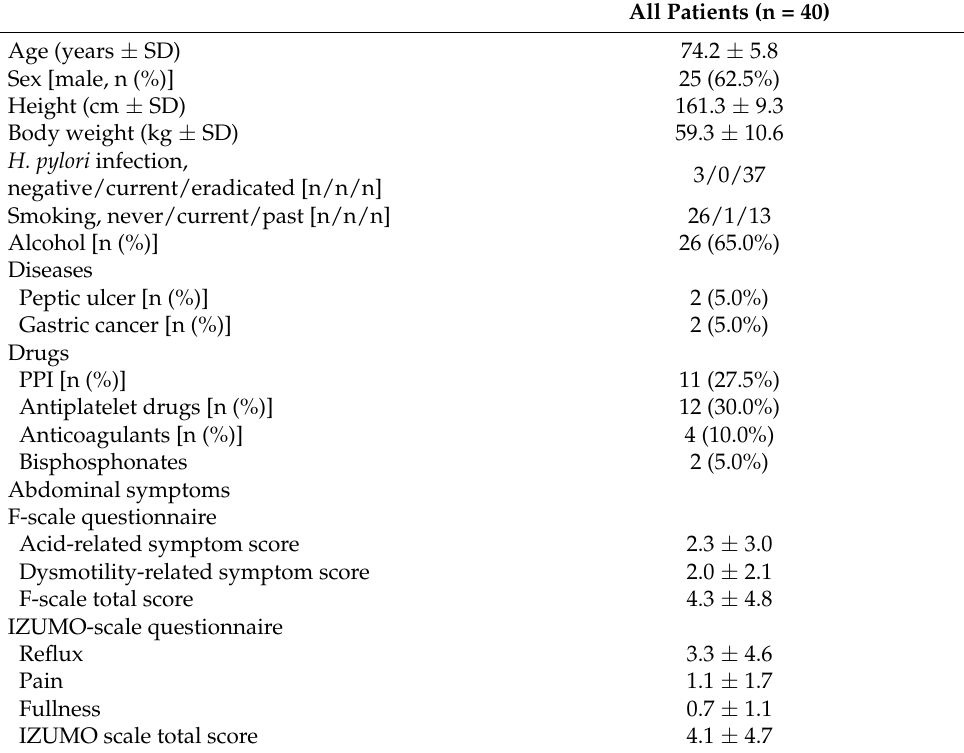
Table 1. Characteristics of patients enrolled in this